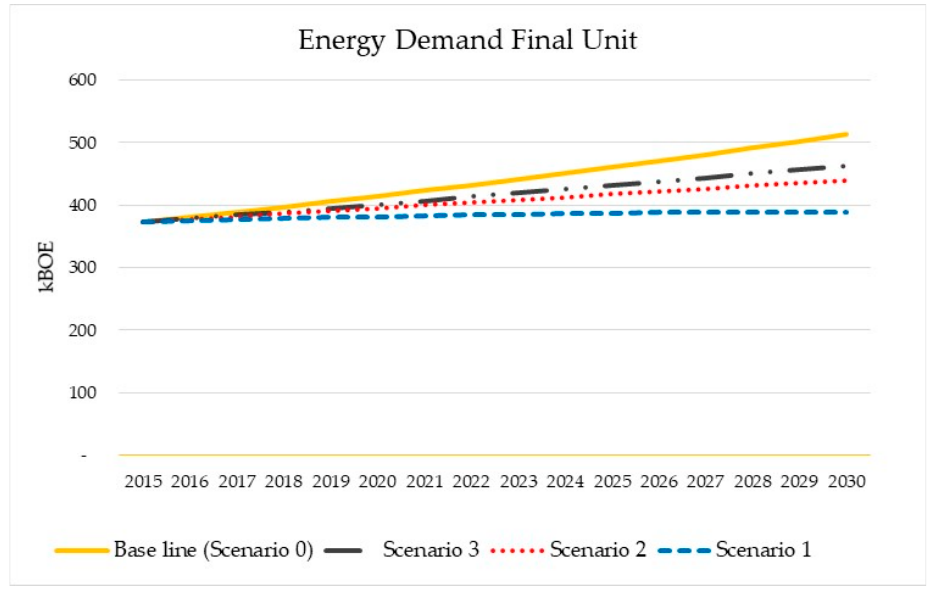
Figure 3. Prospective energy use considering three scenarios.